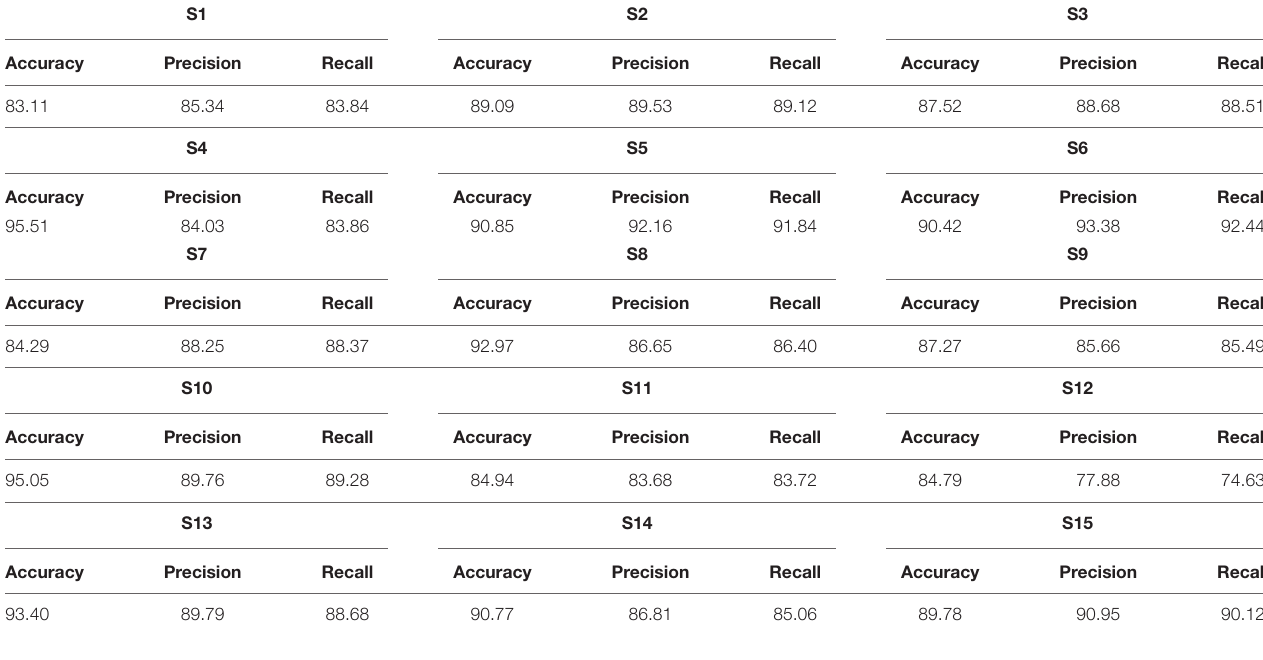
TABLE 2 | Classification accuracies, precision, and recall achieved through proposed long short-term memory (LSTM) network (in